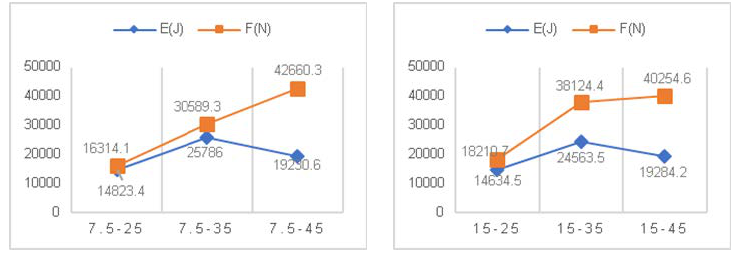
Fig. 8 Data at position 3 ‘waterfall